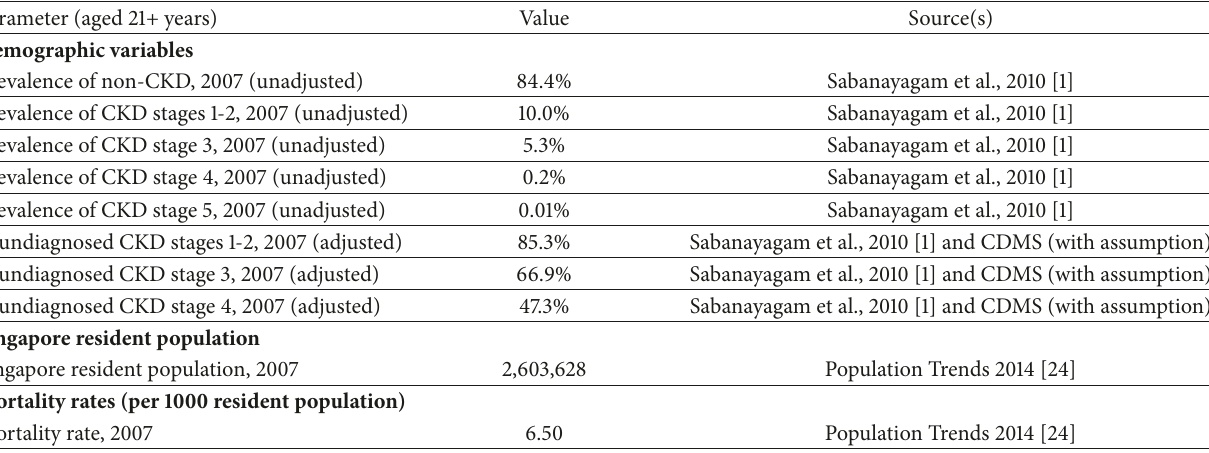
Table 1: Input values for the base year.